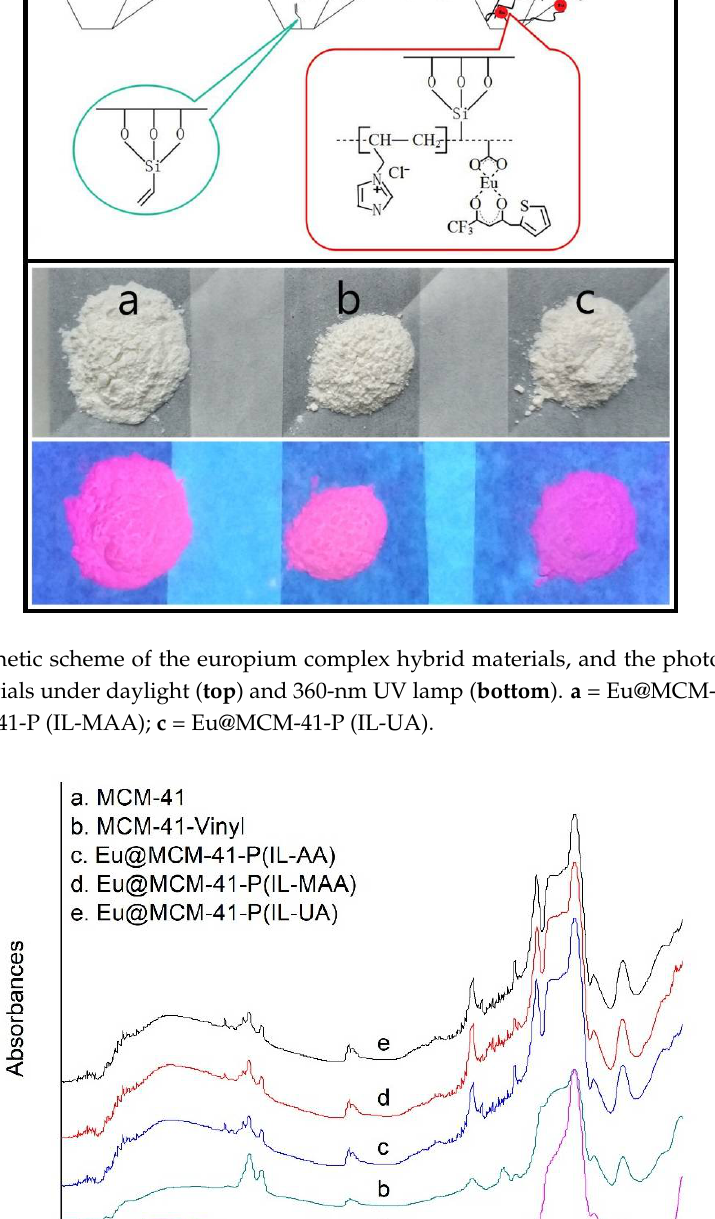
Figure 2. FTIR spectra of MCM-41, vinyl-modified MCM-41 (MCM-41-Vinyl), and the final materials.